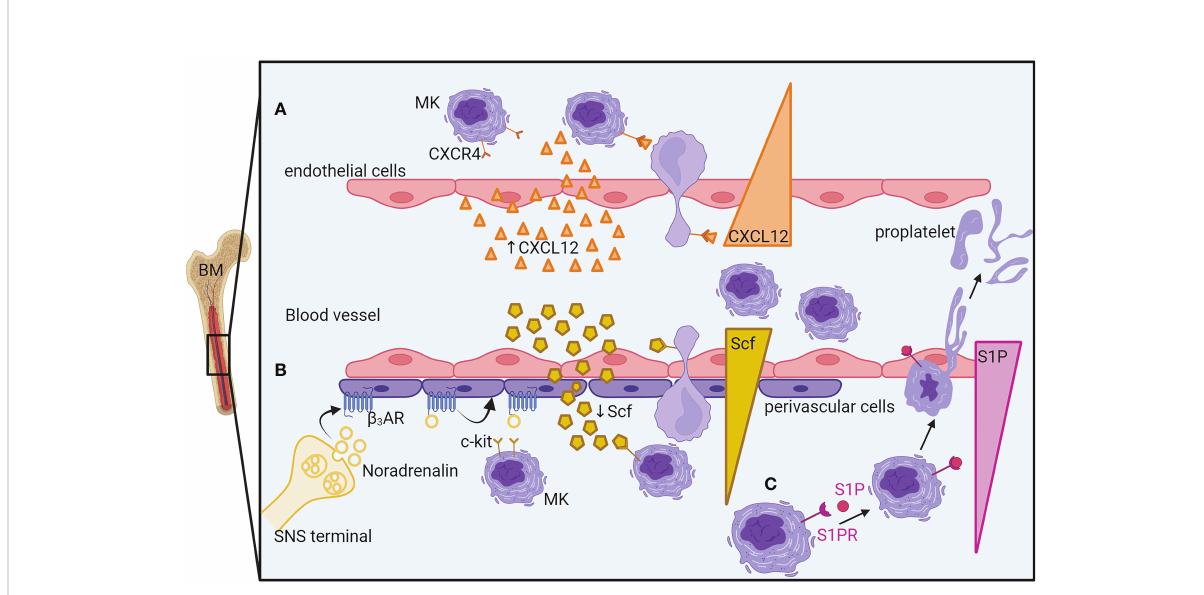
FIGURE 3 Mechanisms of megakaryocyte egress and proplatelet release from the bone marrow. (A) An increase of endothelial cell-derived CXCL12 in the blood guides the MK, thanks to its CXCL12 receptor, CXCR4, close to the sinusoidal vascular niche where it would deform itself to enter the vasculature. (B) During sepsis, the sympathetic nervous system releases noradrenaline, inducing the reduction of perivascular cell-produced SCF in the bone marrow. The SCF gradient between the bone marrow and the blood will guide the MKs to exit in the blood vessels. (C) A higher concentration of S1P in the blood than in the bone marrow guides MK elongation into the bloodstream by S1PR activation. BM, Bone marrow; MK, megakaryocyte; CXCR4, C-X-C chemokine receptor type 4; CXCL12/SDF1, C-X-C motif chemokine 12/ stromal cell-derived factor 1; SCF, Stem cell factor; c-kit/SCFR, Stem cell factor receptor; b 3-AR, beta-3 adrenergic receptor; SNS, Sympathetic Nervous System; S1P, Sphingosine-1-phosphate; S1PR, S1P